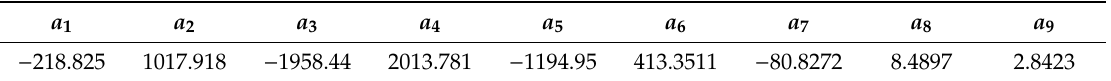
Table 1. Results obtained from fitting of the polynomial in Equation (15).